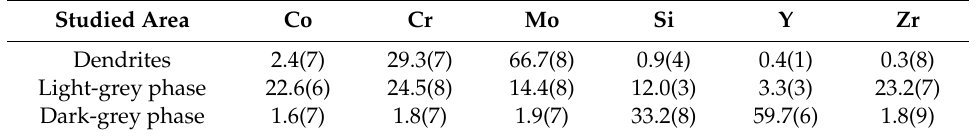
Table 3. SEM energy-dispersive X-ray spectroscopy (EDS) chemical composition (at.%) of all phases in the studied alloy.